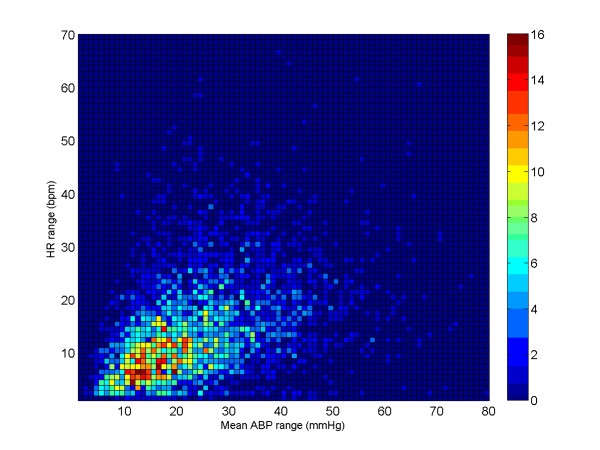
The joint-distribution of true HR range (HRmax-HRmin) and BP range (MBPmax-MBPmin) of the clean dataset for each segment of data comprising 3762 data segments of 1 hour or longer continuous waveform data (1.62 ± 0.69 h).